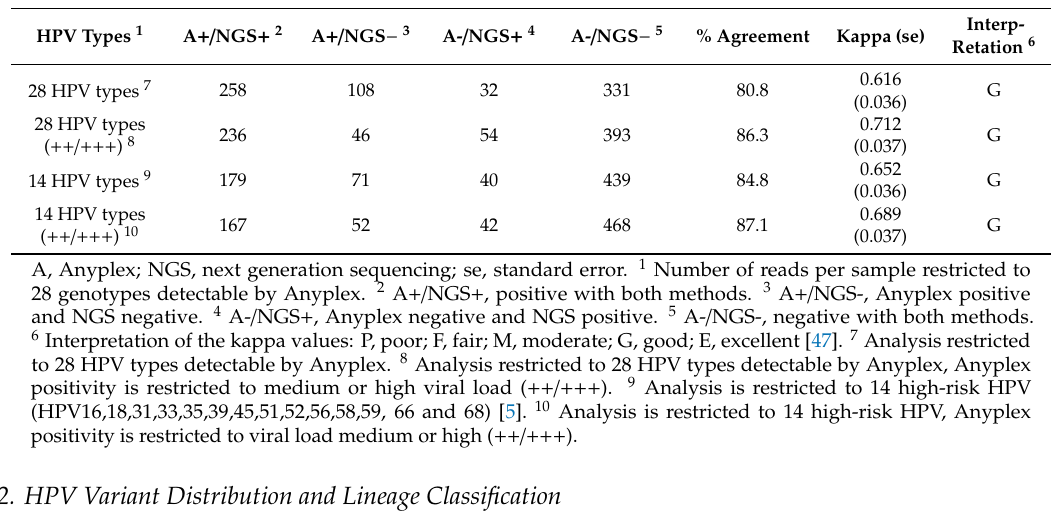
Table 2. Overall agreement for HPV detection between Anyplex II HPV28 and next-generation sequencing.